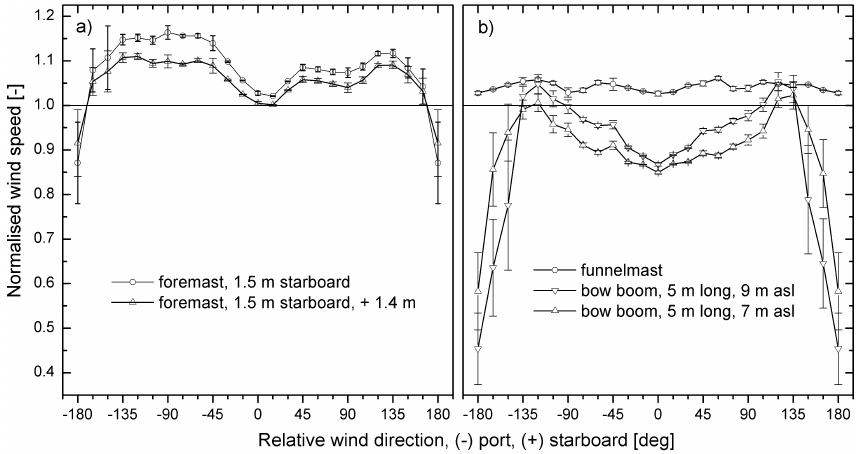
Fig. 3. R/V Mirai : normalised wind speed (as fraction of the undisturbed speed) against relative wind direction at various anemometer locations (see Fig. 1, bottom panel): [1] foremast (23.5ma.s.l.), [2] foremast +1.4m (24.9ma.s.l.), [3], funnel-mast (35.6ma.s.l.), [4] bow boom (7m and 9ma.s.l.). Error bars indicate standard deviation. A bow-on wind is represented by a relative wind direction of 0 ◦